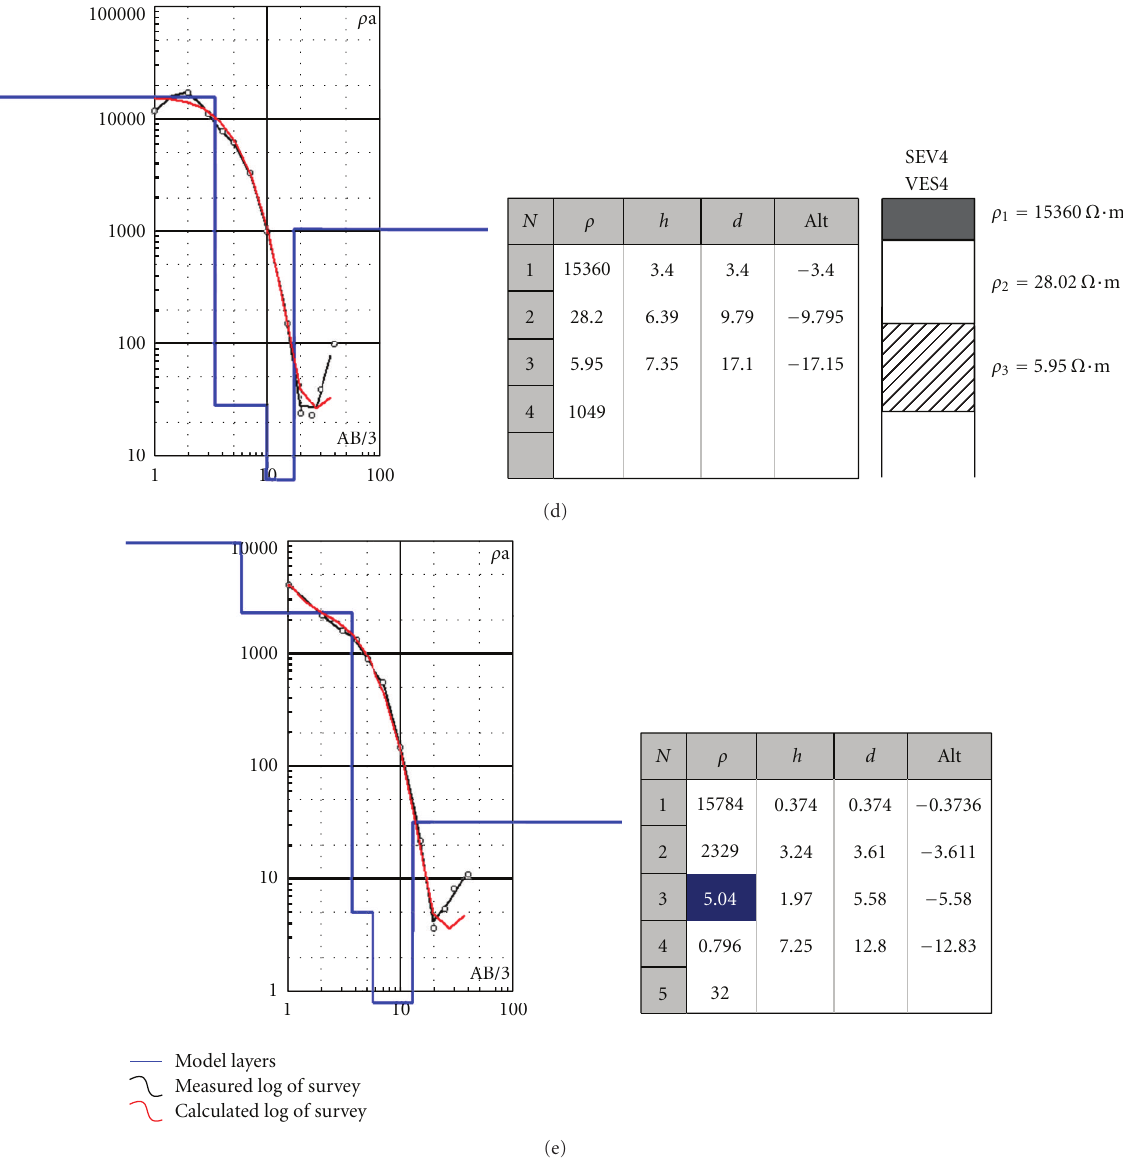
Figure 9: (a) VES1 log and model layers. (b) VES2 log and model layers. (c) VES3 log and model layers. (d) VES4 log and model layers. (e) VES5 log and model